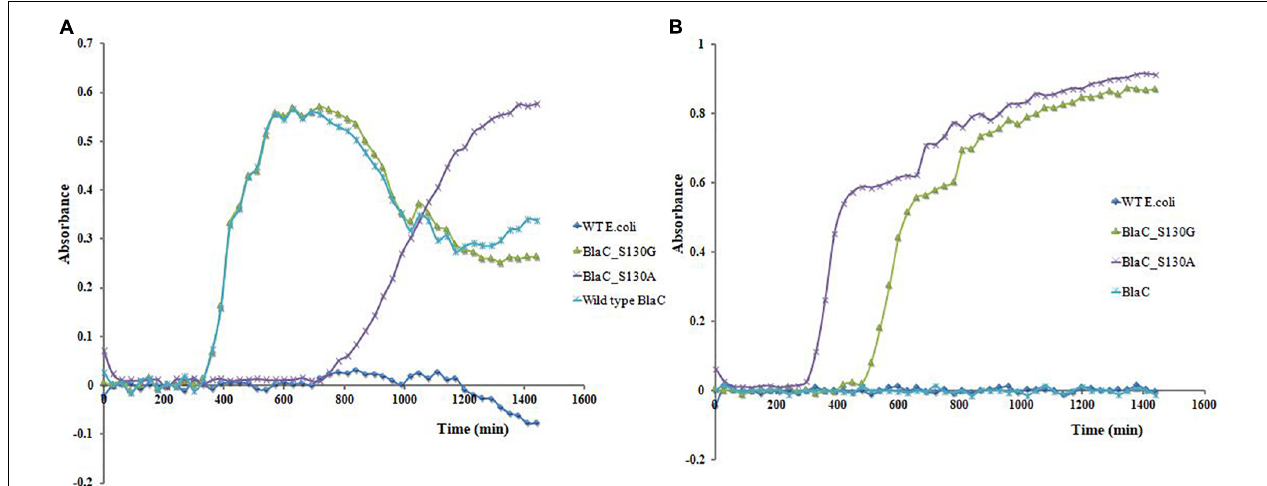
FIGURE 6 | Clone’s growth curve analysis expressing wild-type BlaC, BlaC_S130A, BlaC-S130G, and wild-type Escherichia coli . (A) Growth curve analysis in the presence of 10 µ g/ml of ampicillin. (B) Growth curve analysis in the presence of 10 µ g/ml of ampicillin and 10 µ g/ml of sulbactam (beta-lactam/beta-lactamase inhibitor